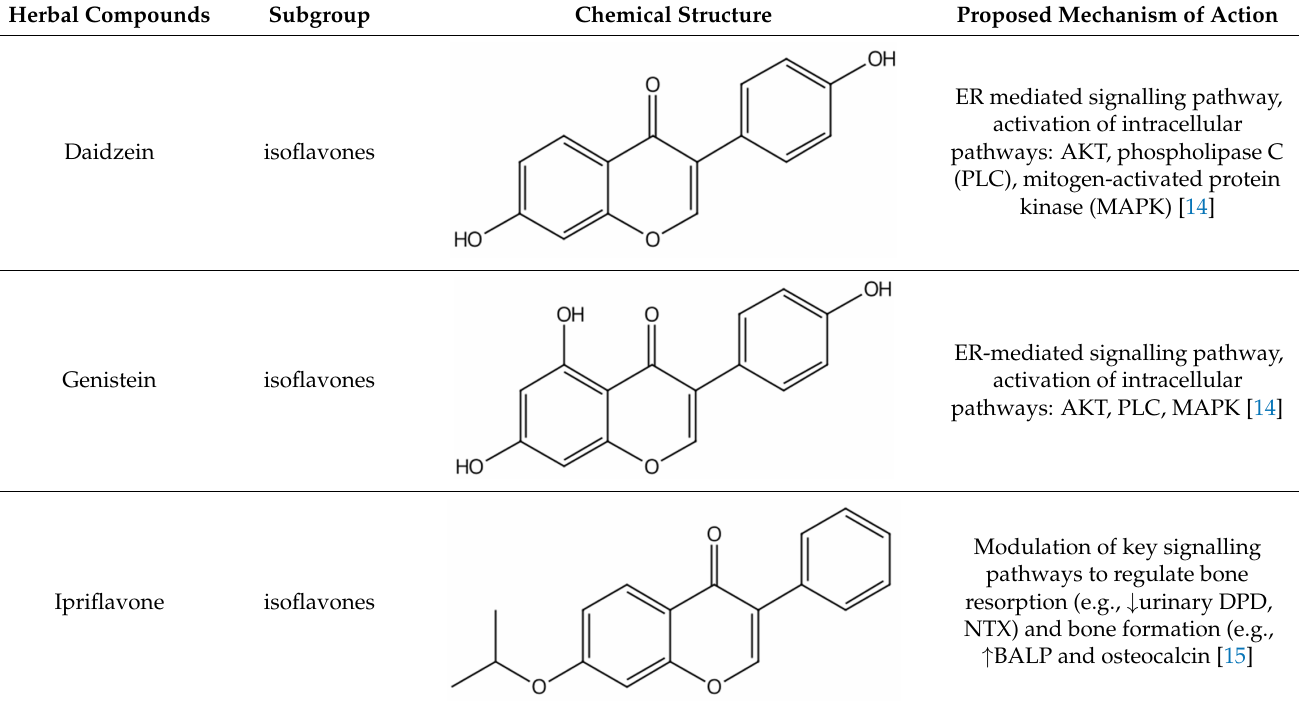
Table 1. Herbal compounds with antiosteoporotic properties investigated in vitro and in animal models. Herbal